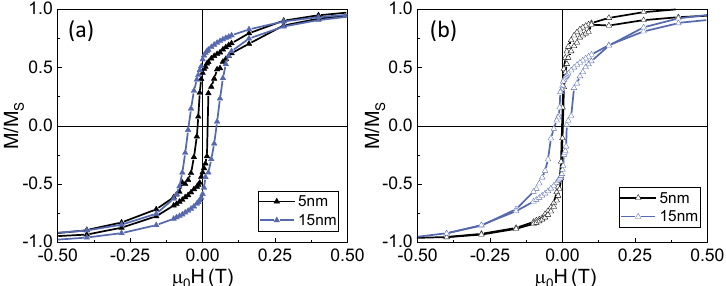
Figure 5. Influence of the thickness of the Au layer on the magnetic properties of FeNi/Au/Co arrays with 5 nm thick Co. Hysteresis loops measured with the field applied ( a ) parallel and ( b ) perpendicular to the longitudinal axis of the